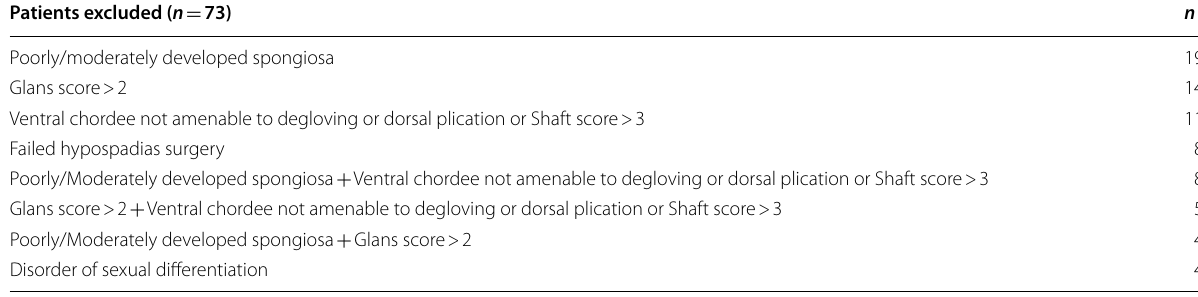
Table 3 Patients excluded from the